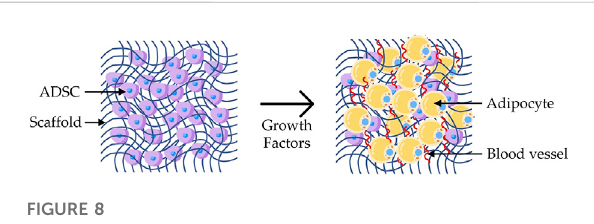
FIGURE 8 Adipogenesis: representation of a scaffold seeded with ADSCs and cultured with growth factors, leading to the differentiation into adipocytes and growth of blood